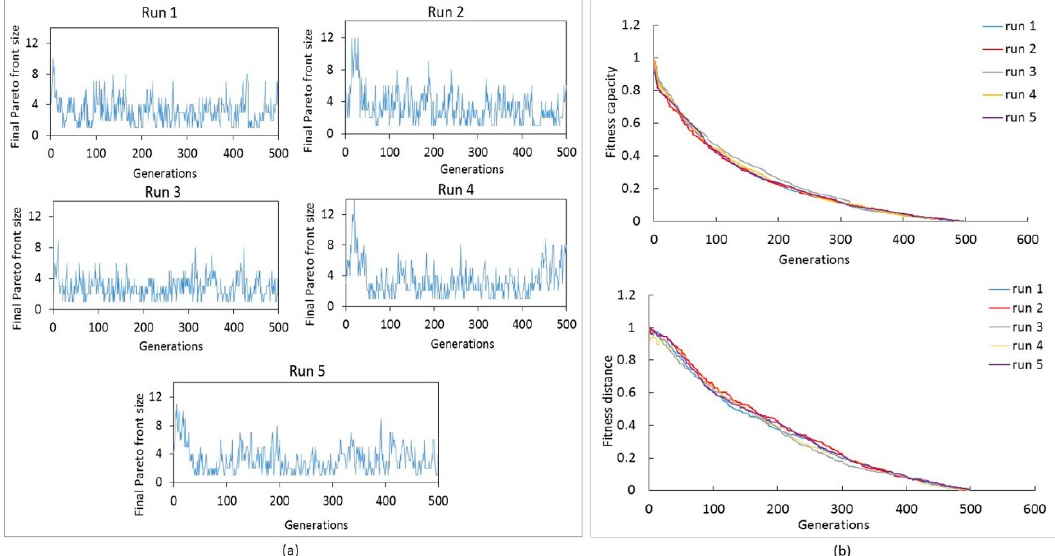
Figure 16. Repeatability of the proposed MOABC algorithm from five runs. ( a ) Variation of Pareto front size with numbers of generations; ( b ) fitness variation of five runs.